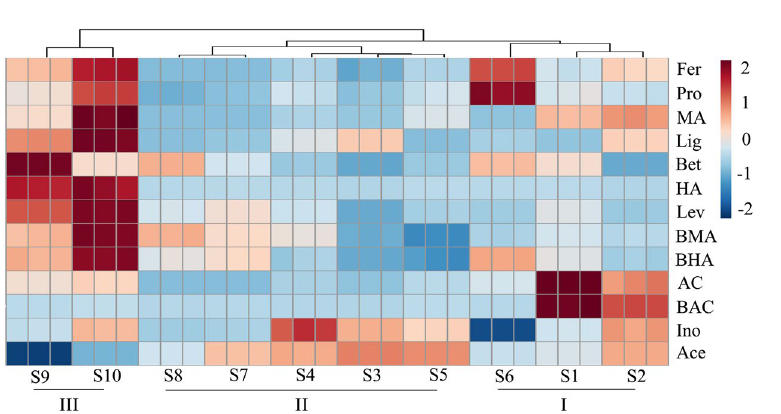
Figure 1. The screening process of Xiaojin Pills’ quality markers based on multi component content determination, COX-2 anti-inflammatory experiment and network interaction analysis.